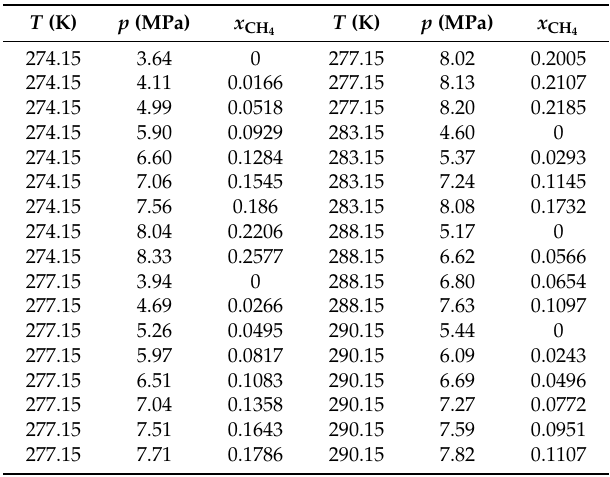
-L CO equilibria (HLLE) for the CH 4 -CO 2 -H 2 O ternary system. 2 O 2